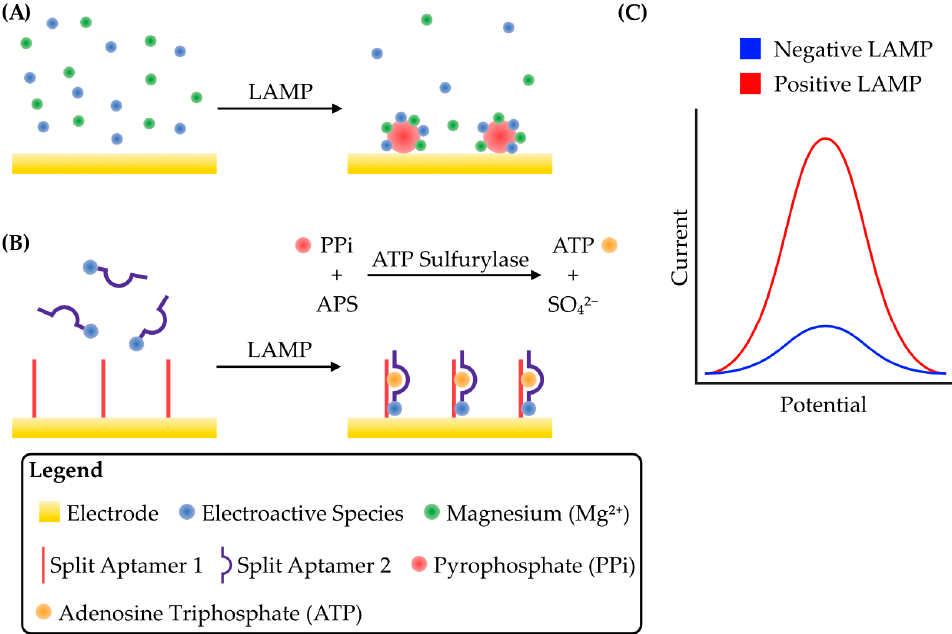
Figure 4. Schematic strategies for the detection of pyrophosphate produced through DNA replication during LAMP. ( A ) Before LAMP, the electroactive species RuHex diffuses freely. Mg 2+ , a cofactor for DNA polymerases, is also present. As LAMP proceeds, RuHex coprecipitates onto the electrode surface with Mg 2+ and the pyrophosphate produced from DNA polymerization, concentrating RuHex on the electrode and greatly increasing the peak faradaic current. Adapted from [72]. ( B ) An ATP-binding aptamer is split in two, with one half (Split Aptamer 1) conjugated to the electrode while the other (Split Aptamer 2), conjugated to an electroactive species, is free in solution. The enzyme ATP sulfurylase catalyzes a reaction between the pyrophosphate (PPi) produced during LAMP and adenosine phosphosulfate (APS) to produce ATP and sulfate (SO 42 − ). The ATP brings the split aptamer together, concentrating the electroactive species on the electrode and producing a large peak current. Adapted from [75]. ( C ) Schematic of a typical voltammogram for these detection strategies. Both strategies result in a concentration of an electroactive species at the electrode surface, either by coprecipitation in A or by aptamer formation in B. The net result in both cases is an increase in peak faradaic current during voltammetry.